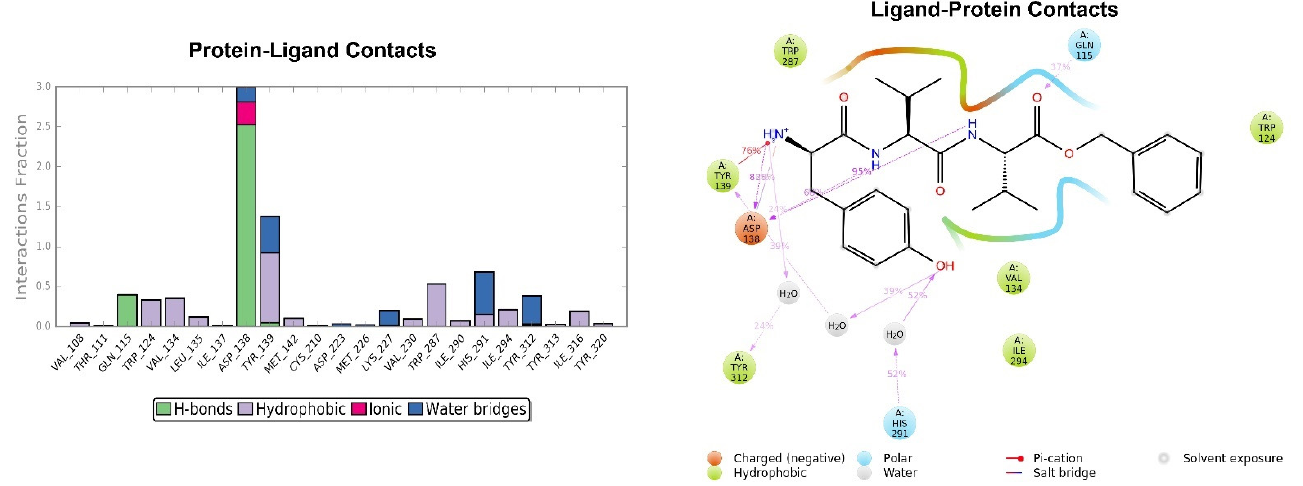
Figure 6. Representation of the main interactions found for H-D-Tyr-Val-Val-OBz in the KOR binding site, expressed in %. Hydrogen bonds are in violet lines.